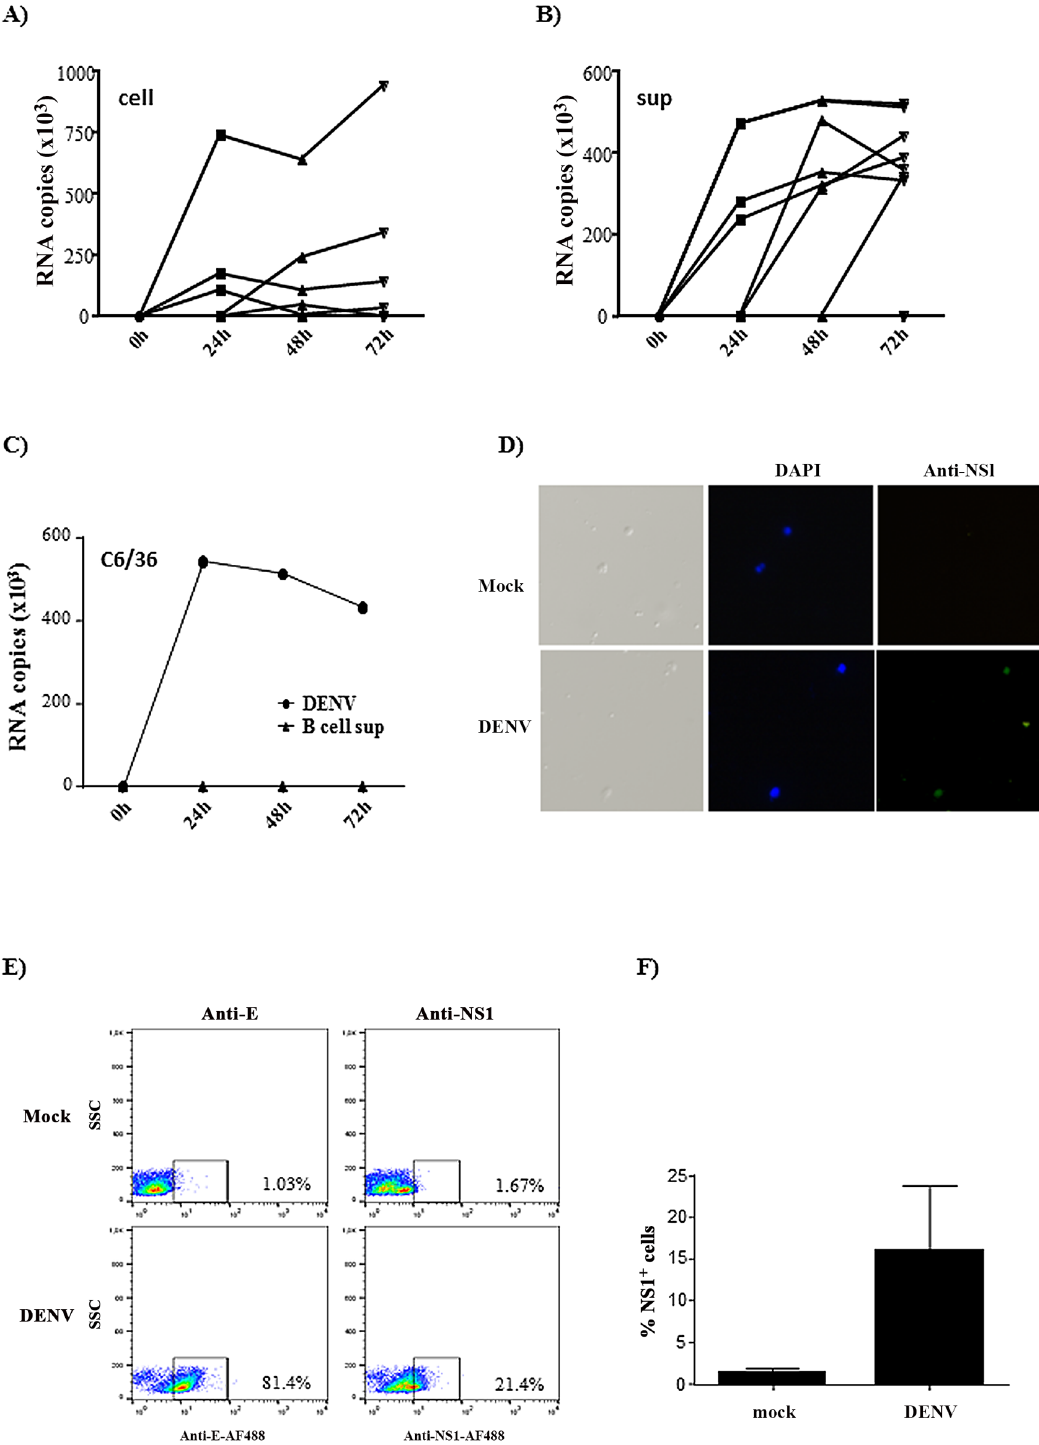
Fig 1. B lymphocytes are susceptible, but poorly permissive to DENV infection. A-B) Purified B lymphocytes were mock-treated or cultured with DENV2 (MOI = 1) for the indicated time points. Cell lysates (A) and supernatants (B) were harvested and virus RNA was measured by quantitative real time RT-PCR. Each line indicate an individual donor after normalization by subtracting the input values. C) C6/36 cell line was incubated with DENV2 (MOI = 1) or with supernatants obtained from B cells previously cultured with DENV. After the indicated time points the cells were harvested and virus RNA was measured by qRT-PCR. D) Purified B cells were mock-treated or incubated with DENV2. After 48h, the cells were incubated with anti-NS1 antibody, followed by anti-